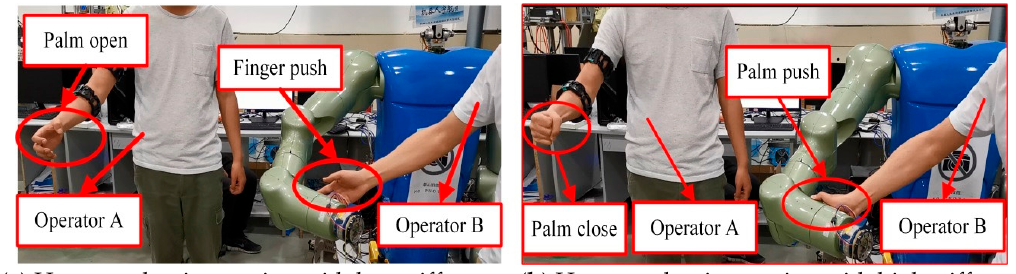
Figure 16. Experimental setup of human robot interaction.